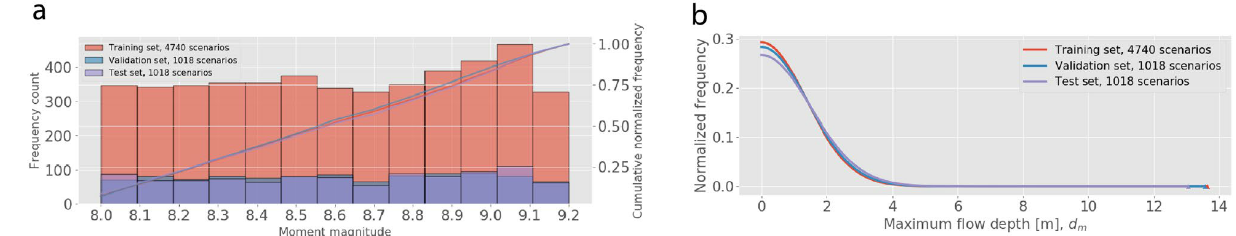
Figure 4. Statistics of the distribution of scenarios among validation, training and test data sets for ViB. ( a ) Distribution as function of moment magnitude (bars) and normalized cumulative frequency. ( b ) Frequency HR } distribution in terms of maximum flow depth max { d . Symbols denote the extrema of each set. Additional plots for other inland gauges can be found in Supplemental